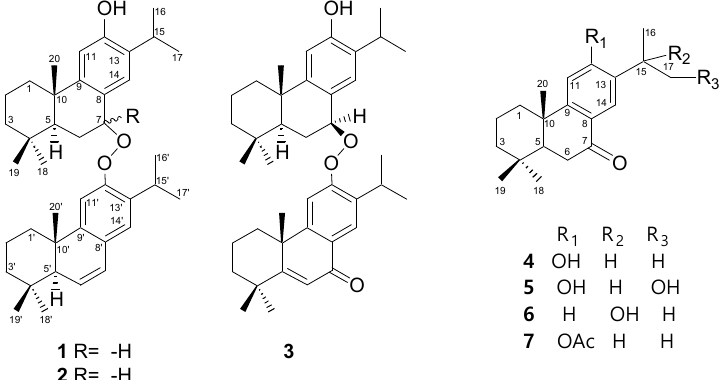
Figure 1. The chemical structures of compounds 1 – 7 isolated from C. japonica.